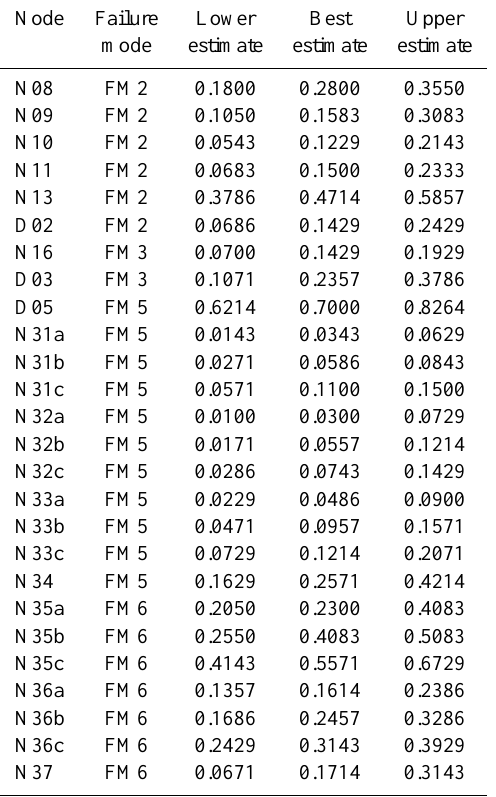
Table 10. Probability estimates for all failure modes (lower, best and upper estimates).